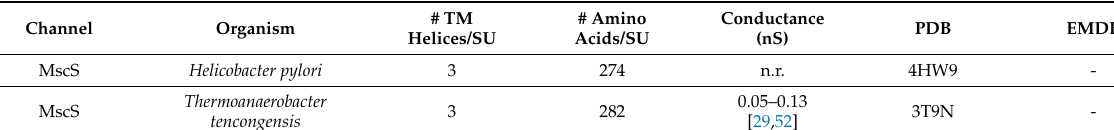
Table 1. Selected properties of MscS and larger homologues with existing models. Not all available models are listed. #—number; SU—subunit; n.r.—not reported; n.m.—not